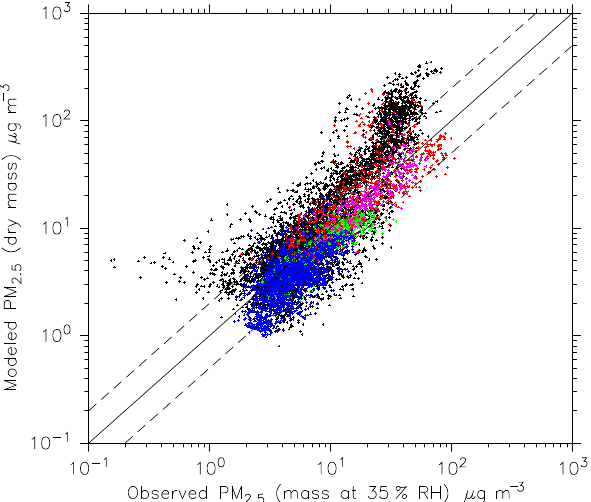
Figure 3. (a) Observed annual mean PM 2 . 5 from (van Donkelaar et al., 2010), (b) simulated annual mean PM 2 . 5 (REF simulation), both in µgm − 3